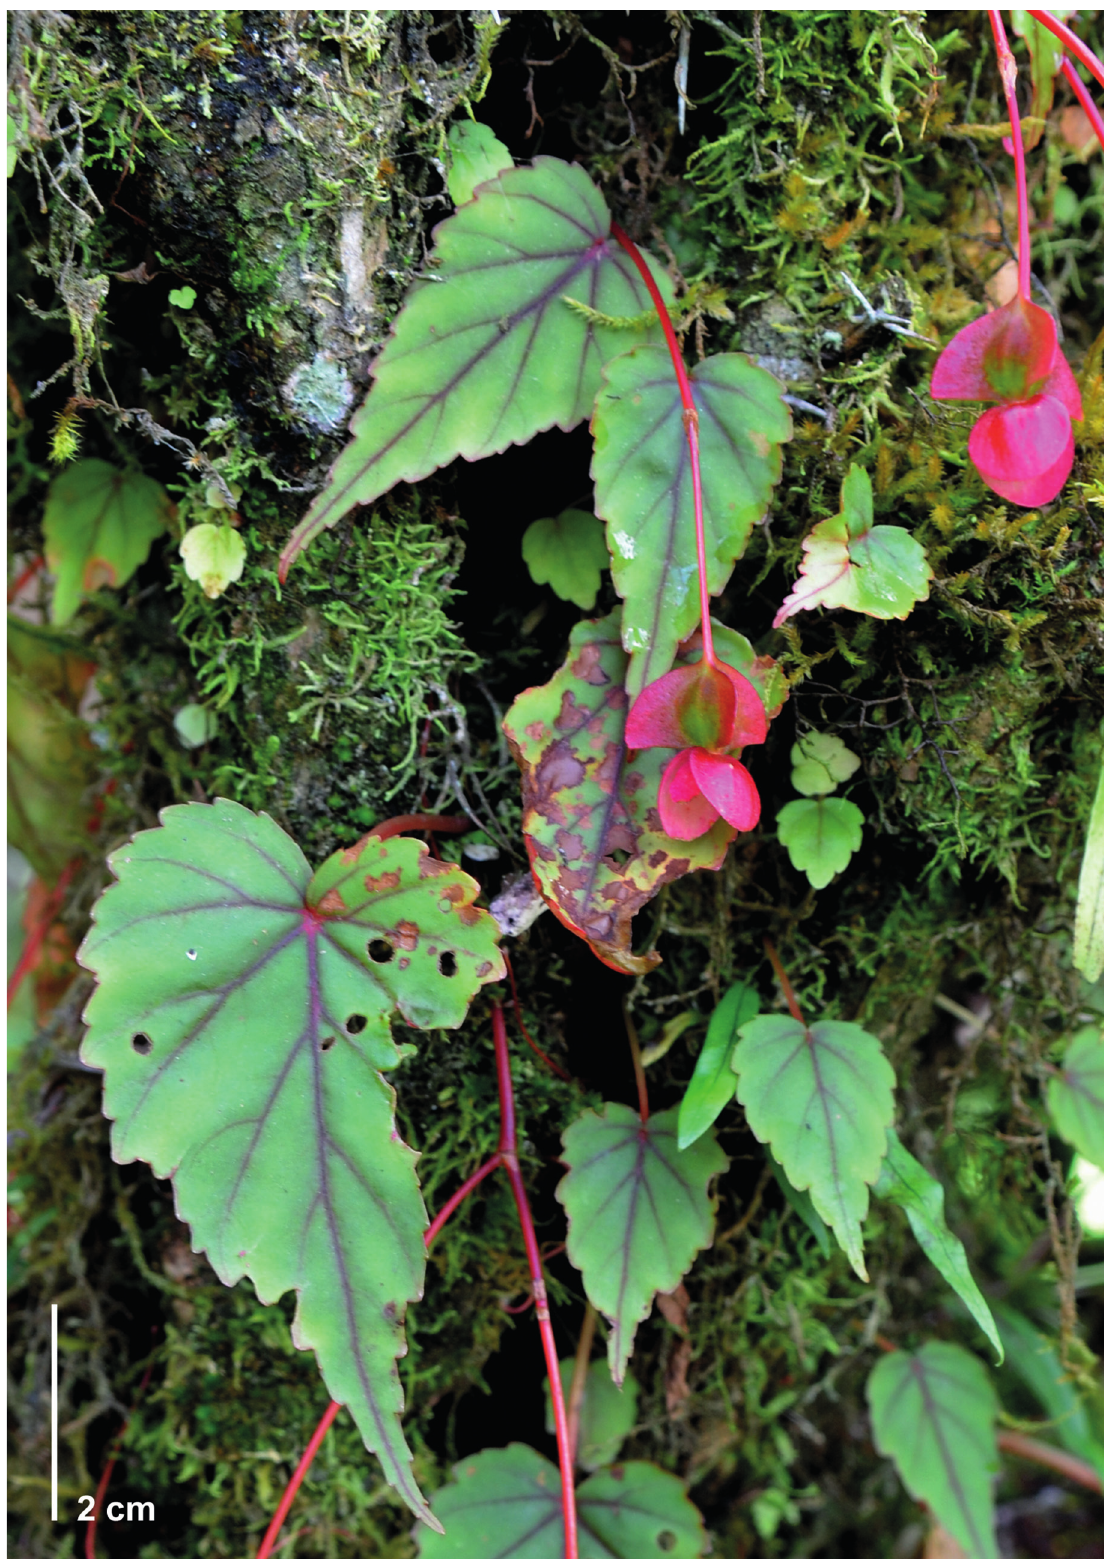
Fig. 23. Photograph showing habit and female flowers of B. dioica Buch.-Ham. ex D.Don. Photograph courtesy of Sangeeta Rajbhandary of a plant in